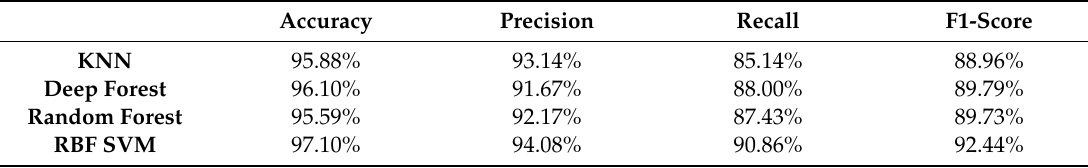
Table 3. Quantitative assessment of vitrinite identification methods * .